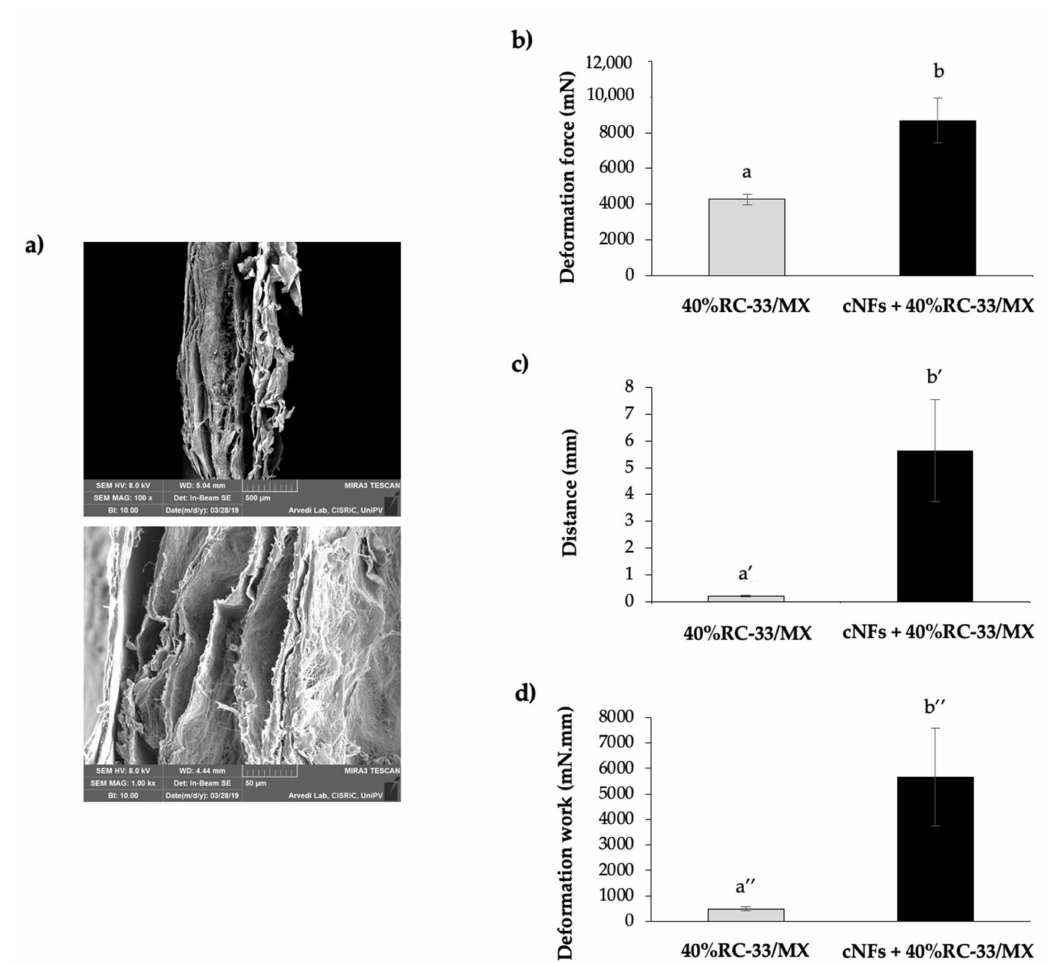
Figure 12. SEM micrographs at two different magnifications (100X at the top and 1.00 kX at the bottom) of composite system cNFs + 40%RC-33/MX ( a ); deformation force ( b ), distance ( c ) and deformation work ( d ); 40%RC-33/MX, in absence of cNFs, was used as reference (mean values ± s.e.; n = 3). Different symbols denote statistically different data ( p ≤ 0.05; One-way ANOVA one-way; t